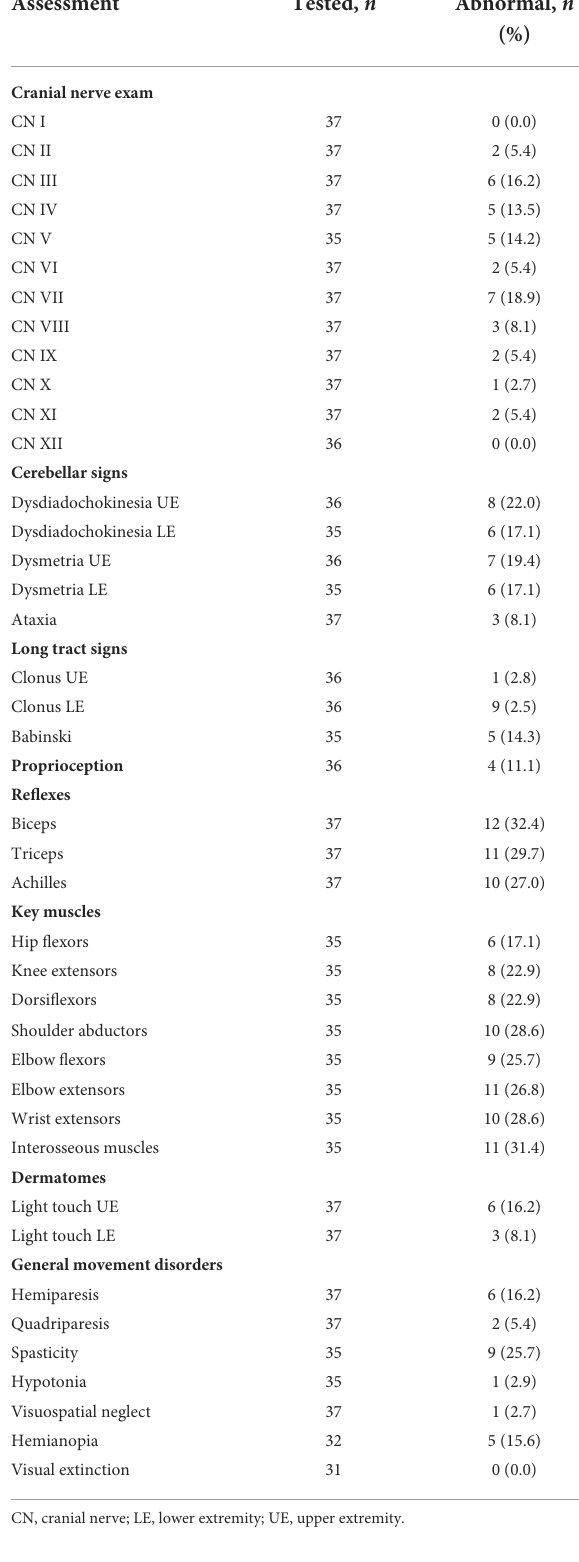
TABLE 3 Neurological exam results of individuals who participated in balance